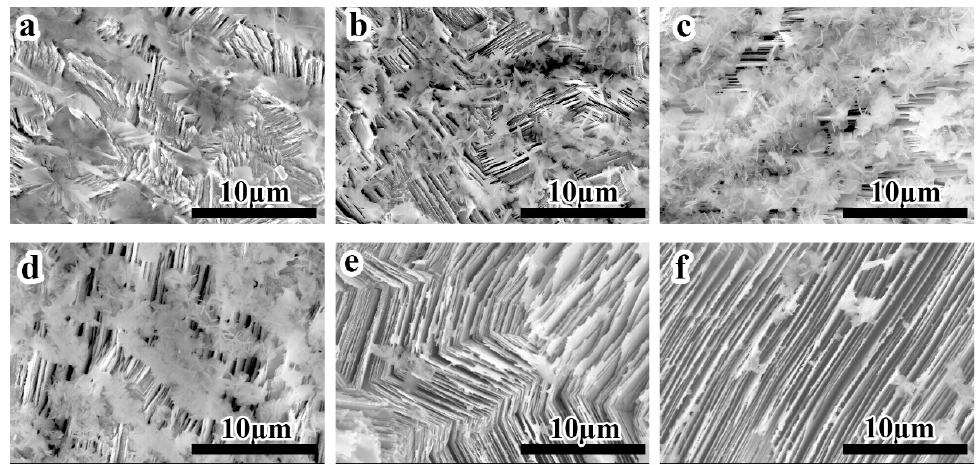
Figure 3. SEM micrographs after anodization for 15 min under different voltage: ( a ) 1 V, ( b ) 5V, ( c ) 10 V, ( d ) 15 V, ( e ) 20 V, and ( f ) 30 V.